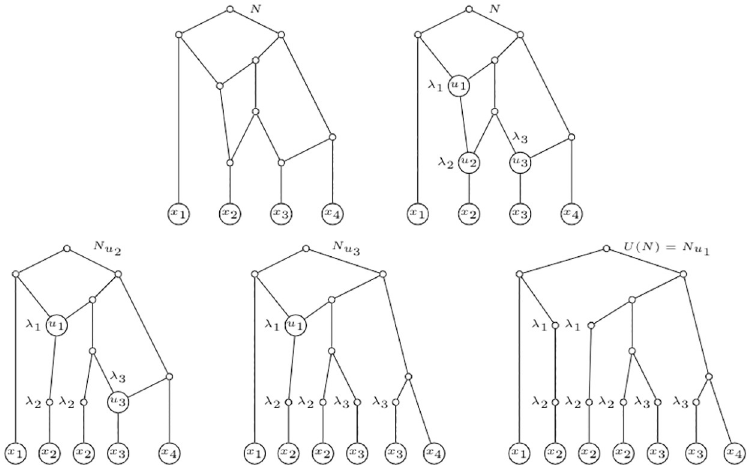
Fig 1. The unfolding of an IMLN. Top two figures: A phylogenetic network N on { x 1 , x 2 , x 3 , x 4 }, and the IMLN obtained by considering the labelling function over R ( N ) given by ℓ ( u i ) = λ i for i 2 {1, 2, 3}. Notice that N is an internally labelled phylogenetic network. The three figures below are the sequence of unfoldings ð N associated to the compatible sequence of reticulations ( u 2 , u 3 , u 1 ). Following the introduced terminology, ¼ U ð N ; u Þ , N ¼ U ð U ð N ; u Þ ; u Þ and N ¼ U ð U ð U ð N ; u Þ ; u Þ ; u Þ ¼ U ð N Þ . Note that u 2 , u 3 2 R min ( N ) and N 2 2 3 2 3 1 u 2 u 3 u 1 u 1 = 2 R min ( N ), there is a path from u 1 to u 2 in N